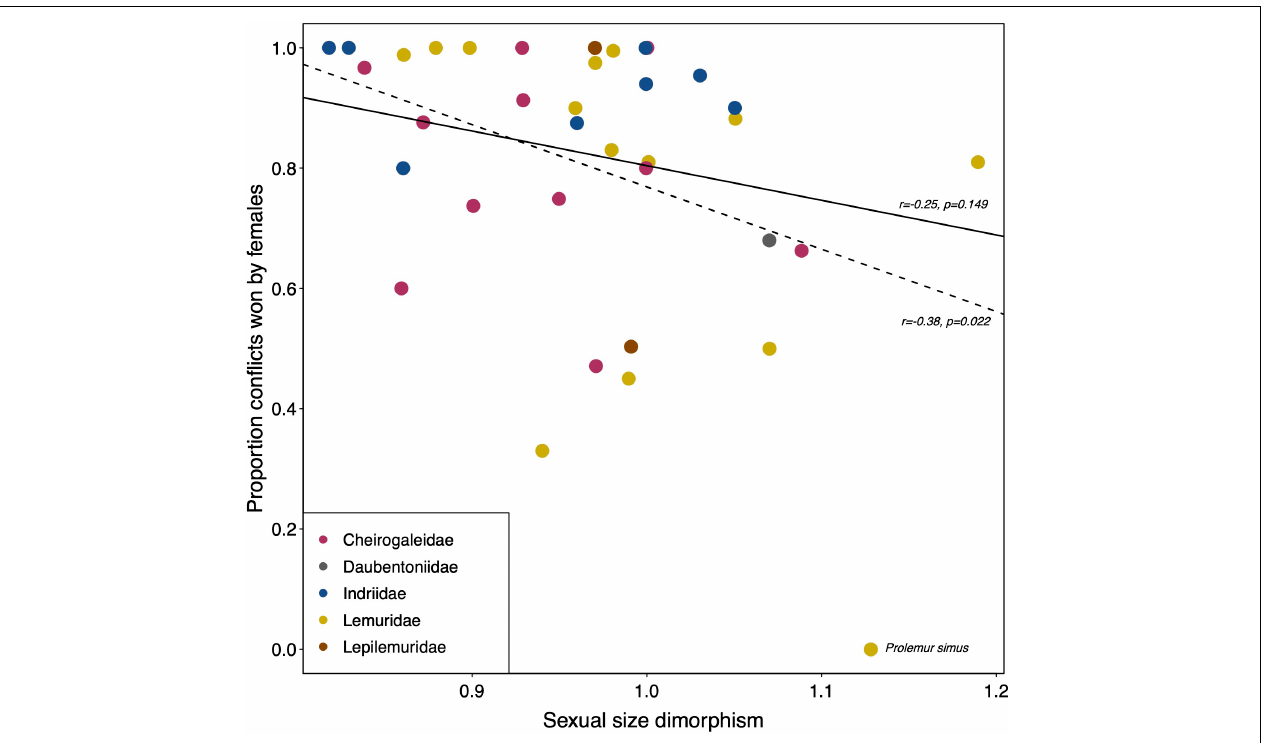
FIGURE 1 | Relationships between the average sexual size dimorphism in body mass and the average proportion of conflicts females won over males across the members of different lemur families. Dashed line indicates the Pearson correlation including Prolemur simus ; solid line presents the correlation excluding P. simus. All data from Table 1